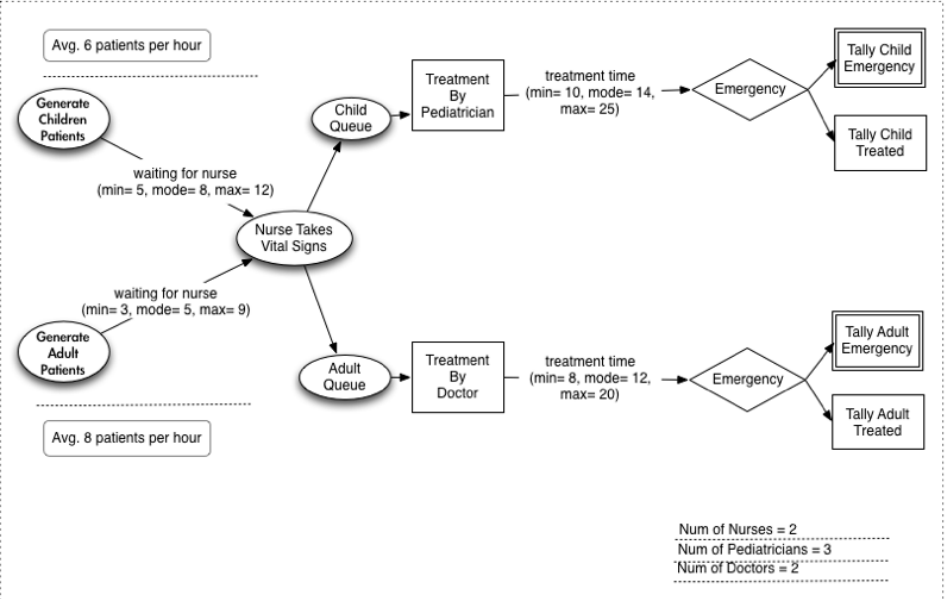
Figure 1. Process flow diagram for urgent care clinic.